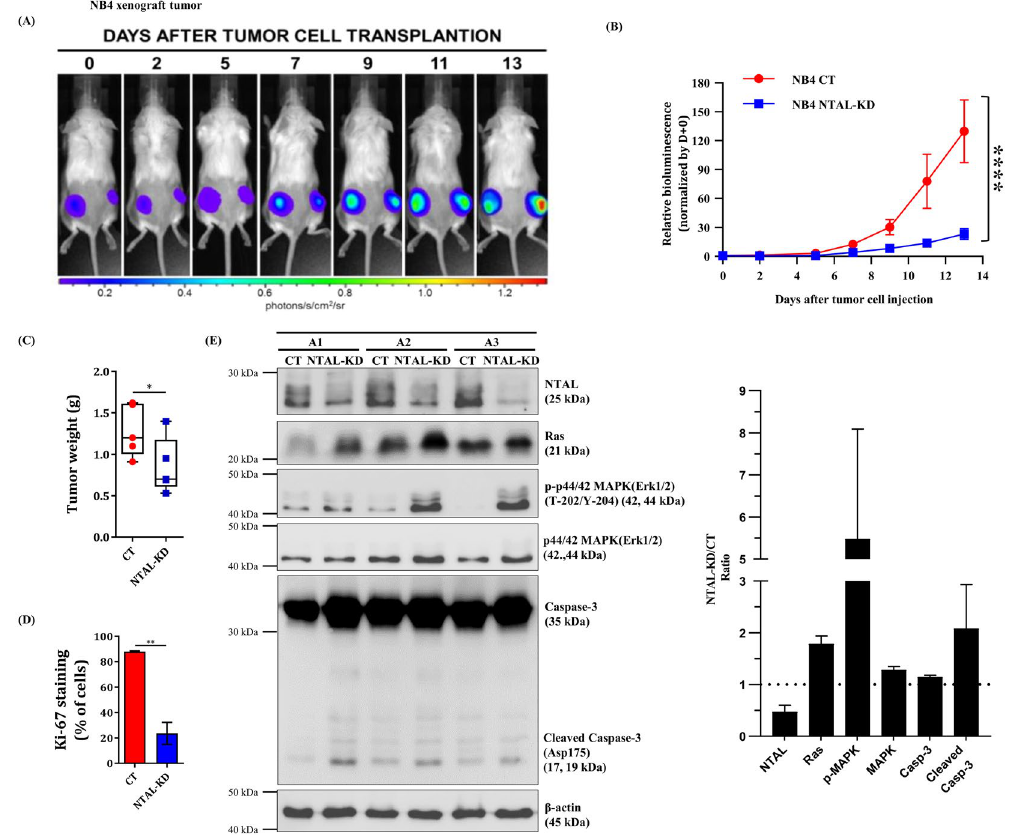
Figure 3. Characterization of the xenograft model of the NB4 cell line in NSG mice. Female 12-week-old NSG mice were injected subcutaneously into the left thigh with 1 × 10 6 non-T cell activation linker - knockdown ( NTAL-KD) cells, and received an equal number of control (CT) cells in the right thigh subcutaneously. ( A , B ) Relationship between bioluminescence and size of the tumor mass. The bioluminescent signal intensity was measured 2, 5, 7, 9, 11, and 13 days after injection of CT tumor cells (right flank) and NTAL-KD cells (left flank) expressing GFP-LUC. Images were acquired with IVIS Lumina representing the location of the cells and the tumor size. ( C ) After 2 weeks, the animals were euthanized and the tumors excised, weighed and processed. A graph of tumor masses derived from NB4 (CT and NTAL-KD) after two weeks: NB4: CT (1.286 g ± 0.3137) and NTAL-KD (0.8540 g ± 0.3402) (n = 5, P = 0.0143 ). ( D ) Immunohistochemical detection quantitative analysis of Ki67 proliferation marker. Data are reported as means and standard deviations. ( E ) Western blot analysis of proteins NTAL, total Ras, p-p44/42 MAPK (ERK1/2-Thr202/204), total p44/42 MAPK (ERK1/2) and caspase-3 tumors originating from NB4 (CT and NTAL-KD) (animals A1 = 1, A2 = 2 and A3 = 3). Bar graphs show the NTAL-KD to CT ratio from the three animals analyzed. Values are show as the mean ±